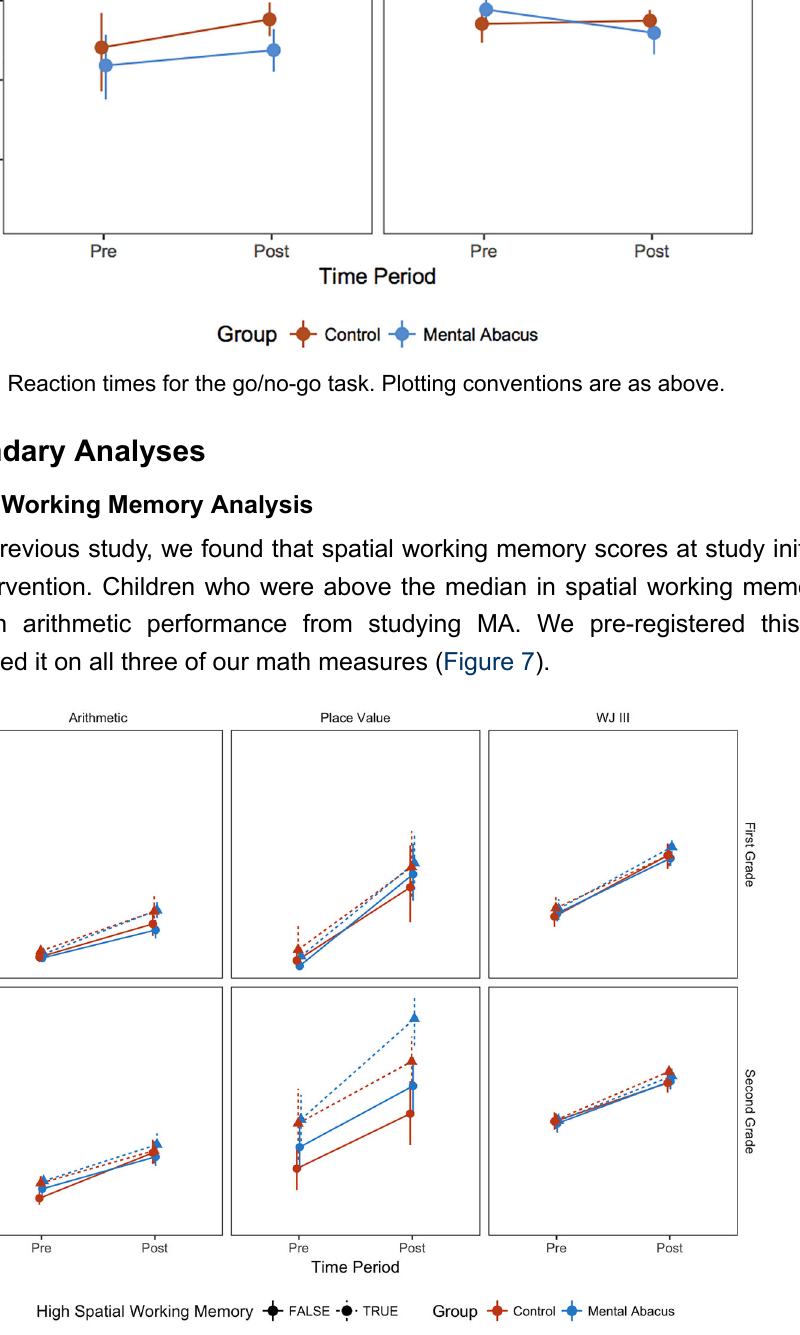
Figure 7. Median split results for outcome measures based on intervention group and spatial working memory scores. Plotting conventions are as